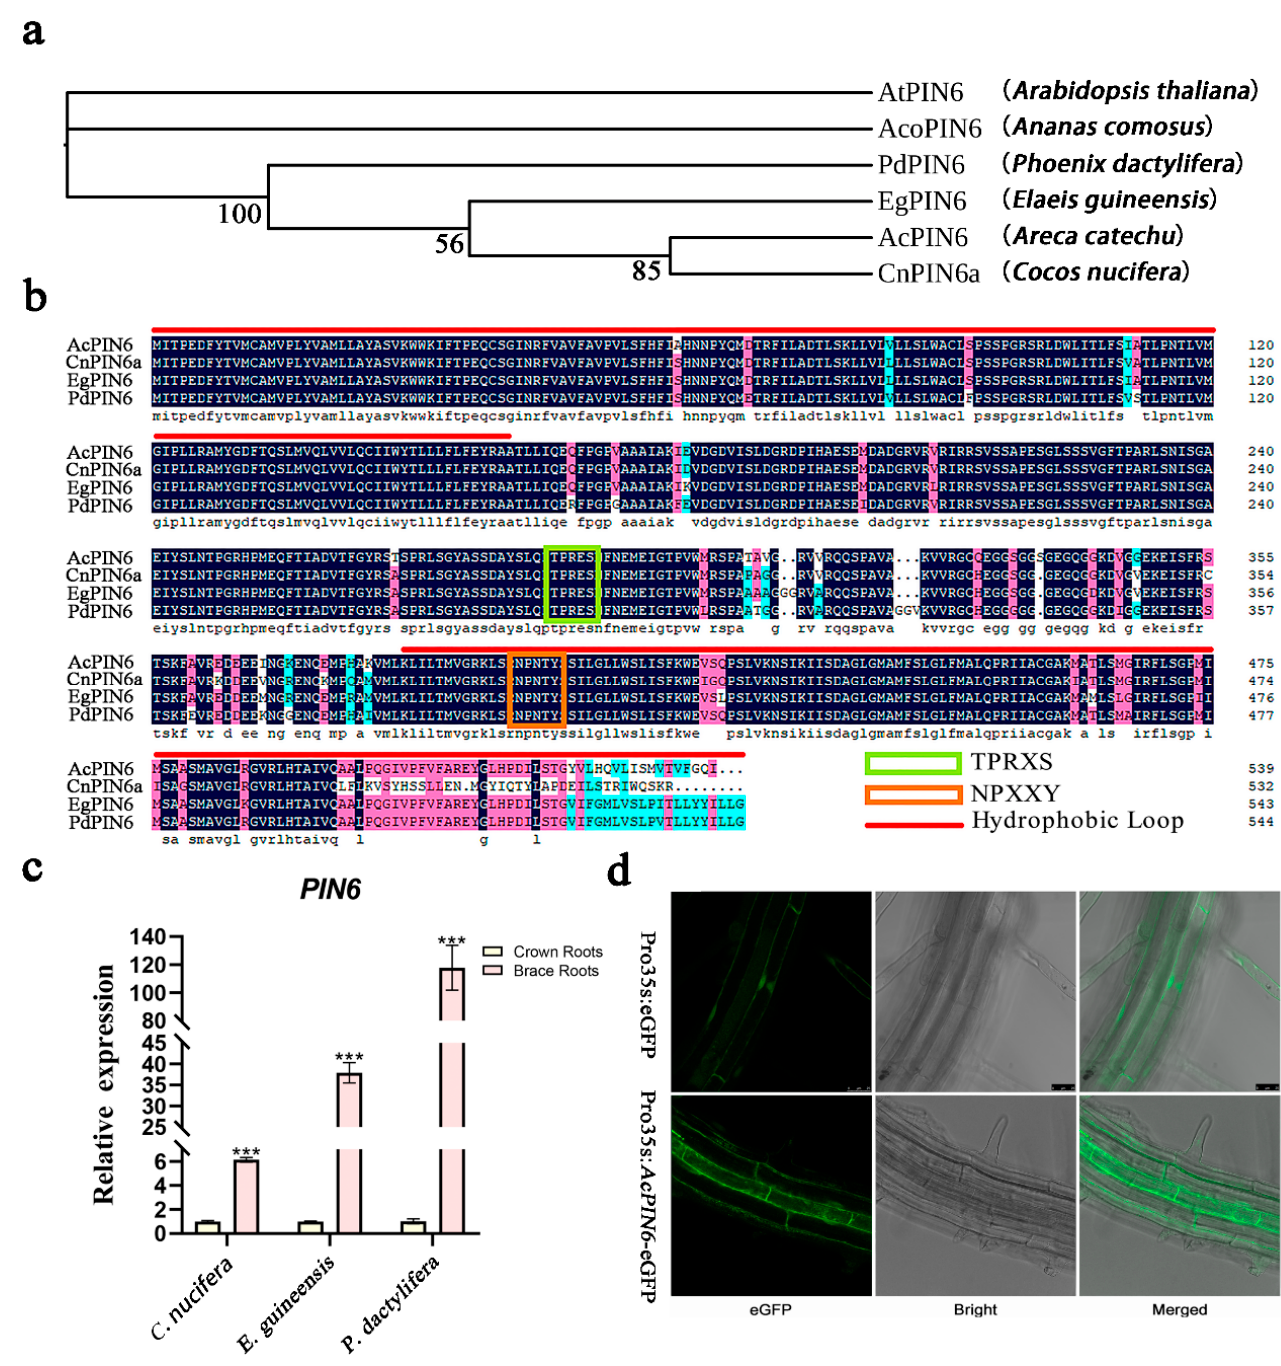
Figure 5. Palmae species PIN6 proteins amino acid sequence multiple alignment and expression levels in crown roots and brace roots. ( a ) Evolution of PIN6 in multiple species. ( b ) Amino acid sequence multiple alignment. The red line indicates a conserved transmembrane domain. The possible functional sites or elements are encircled by a box. ( c ) qRT-PCR analysis of PIN6 in crown and brace roots of Palmae plants. ( d ) Subcellular localization of AcPIN6 . Error bars represent mean ± SE from three independent experiments (*** p < 0.001).